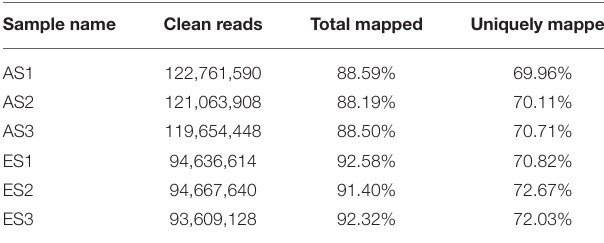
TABLE 1 | Summary of RNA-Seq data and